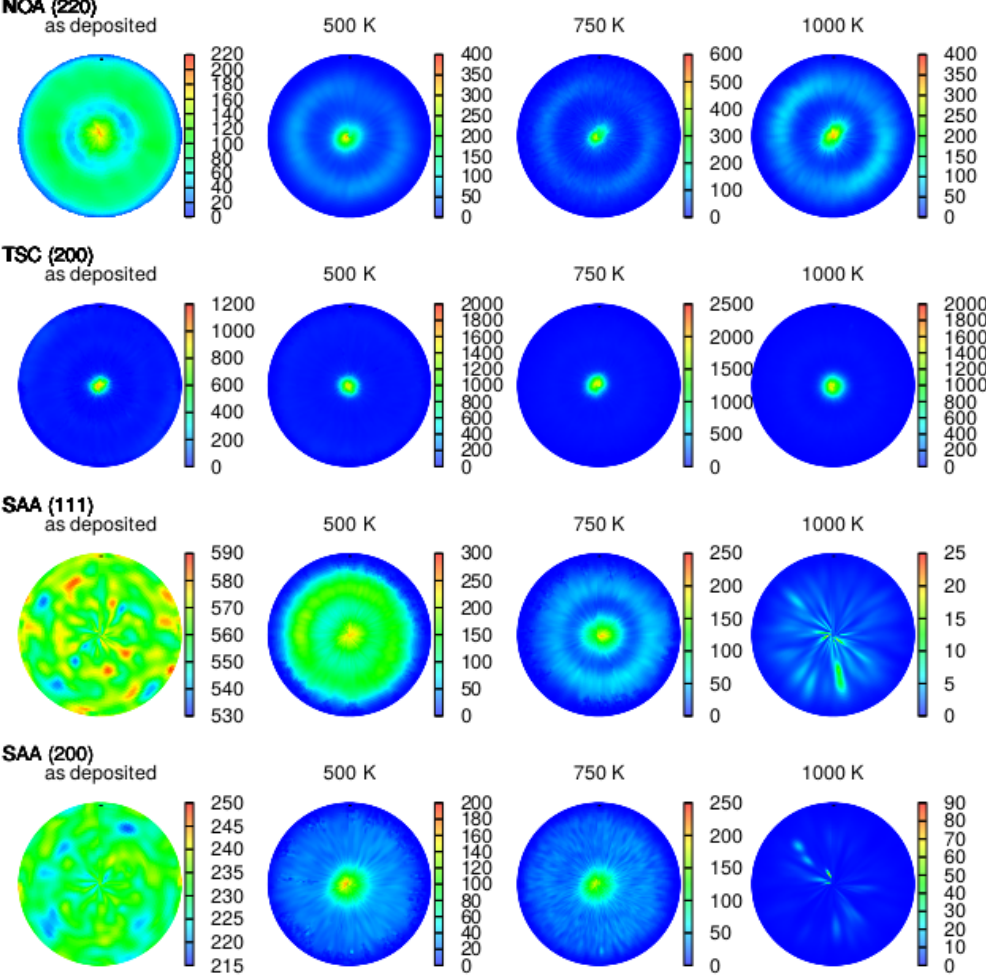
Figure 9. Pole figures for samples NOA, TSC, and SAA before and after heat treatments at different temperatures. For each sample, that pole figure was displayed which reflects best the evolved